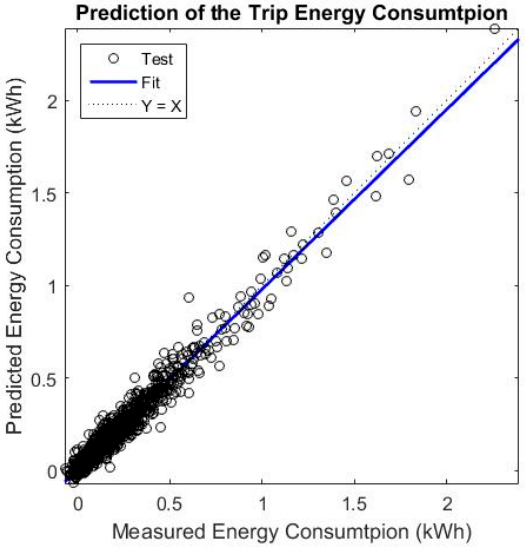
Figure 10. Regression plot for the NN–MLR prediction of the energy consumption on the trips in Dataset 2. in Dataset